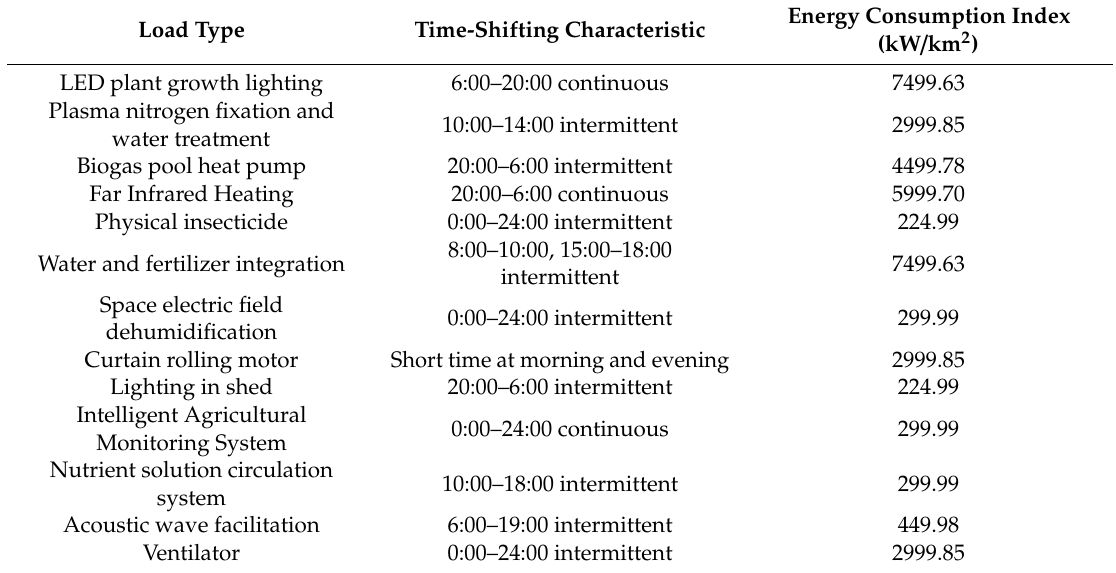
Table 2. The time-shifting characteristics of agricultural greenhouse